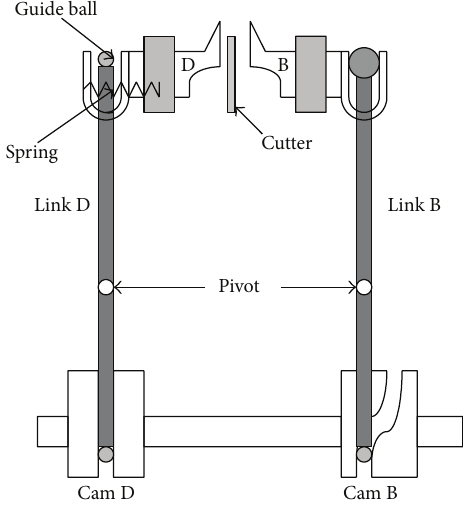
Figure 1: Schematic cam-driven fixture